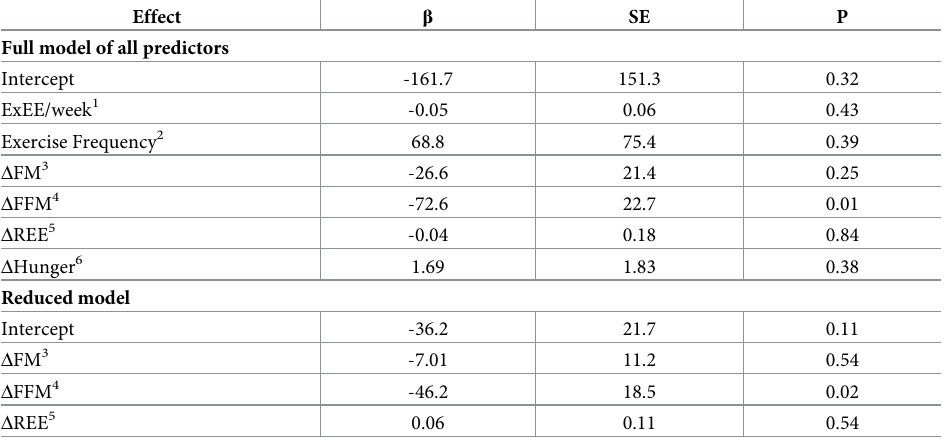
Table 5. Quantile regression models predicting changes in total food reinforcement (P max Total) among partici- pants who exercised for 12 weeks at a frequency of either two or six days per